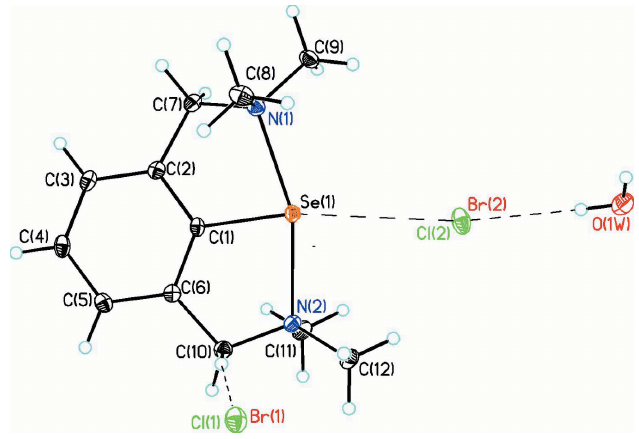
Figure 1 The molecular structure showing 30% displacement ellipsoids. Hydrogen bonds are shown as dashed lines.